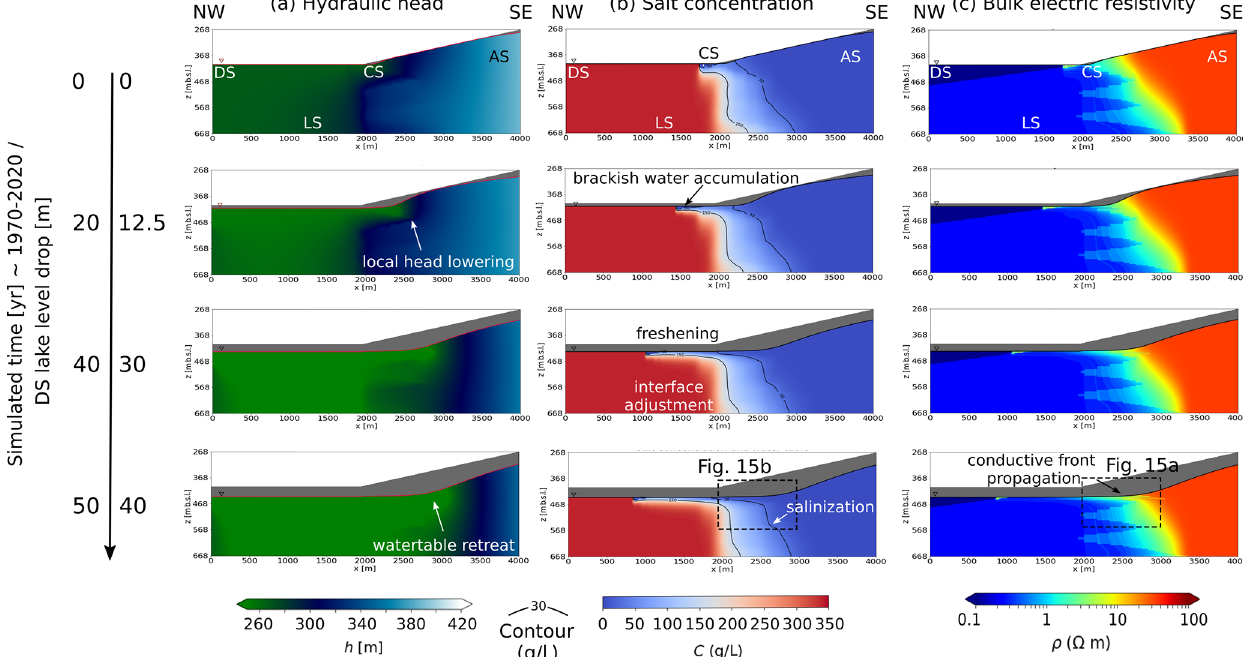
Figure 14. Hydrogeological final model results incorporating a simulated conduit network. (a) Water head distribution. (b) Salt concentration with 150 and 30gL − 1 contours, and (c) bulk soil electric resistivity. Left scale shows different Dead Sea regression phases with an indication of vertical drop. LS stands for lacustrine sediments; AS are the alluvium sediments; DS is the Dead Sea and CS stands for the conduit system. The grey areas correspond to the unsaturated zone – i.e. the area above the water table. See Fig. 15 for a more detailed view on flow, resisitivity and